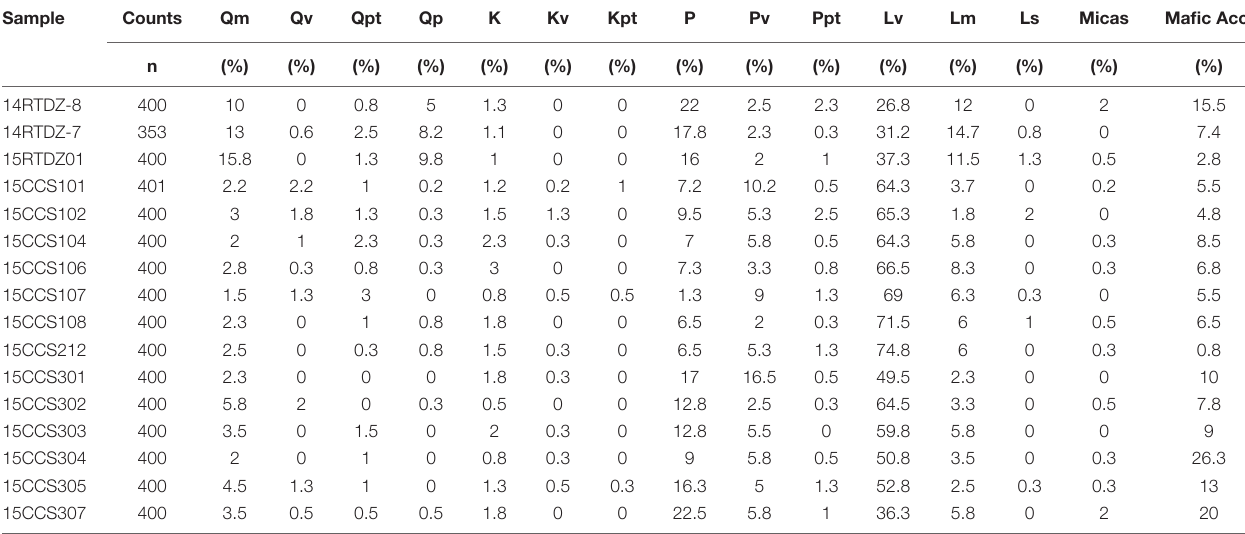
TABLE 3 | Recalculated modal sandstone composition data.